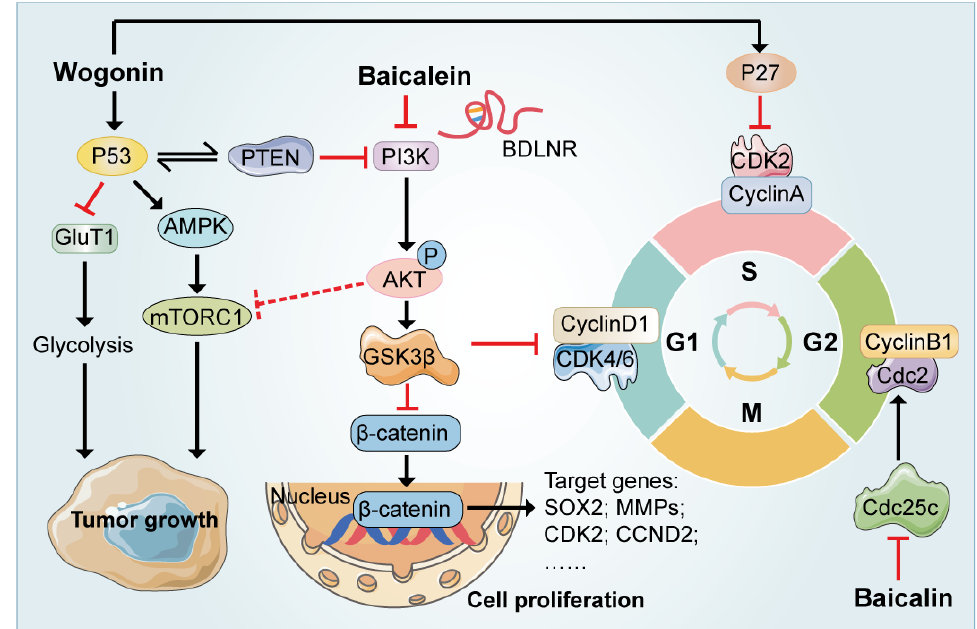
Figure 1. Mechanism of baicalein, wogonin, along with their glycosides (baicalin and wogonoside) in inducing cell cycle arrest and regulating the canonical tumor-associated signaling pathway. Baicalin and wogonin induced cancer cell cycle arrest by regulating cyclin proteins (such as cyclin A, cyclin B1 and cyclin D1). Meanwhile, baicalein and wogonin promote cancer cells apoptosis and inhibit proliferation via PI3K-AKT and AMPK-mTOR pathways, respectively.